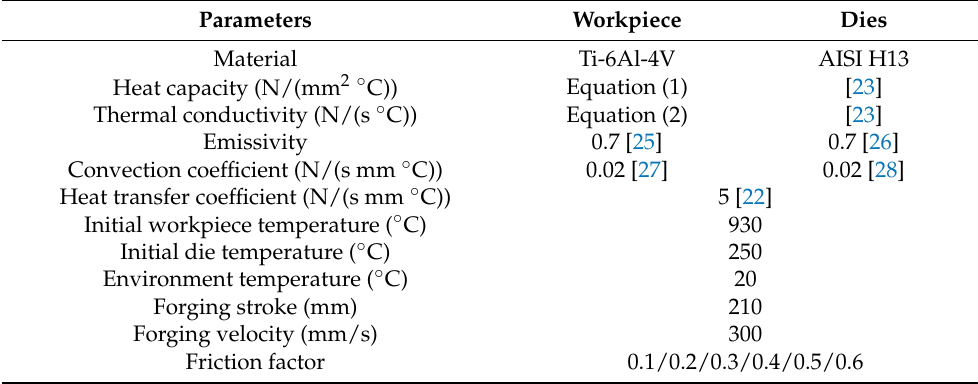
Table 1. The critical thermal parameters of materials and hot forging procedure. Parameters Workpiece Dies Material Ti-6Al-4V AISI H13